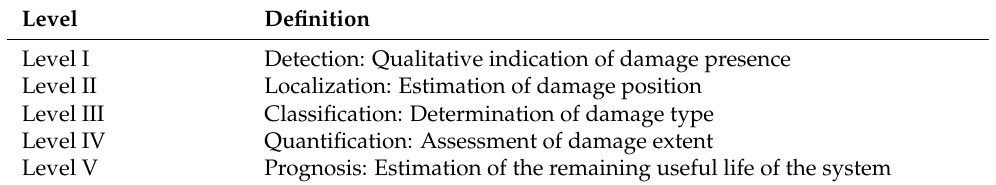
Table 1. Damage identification